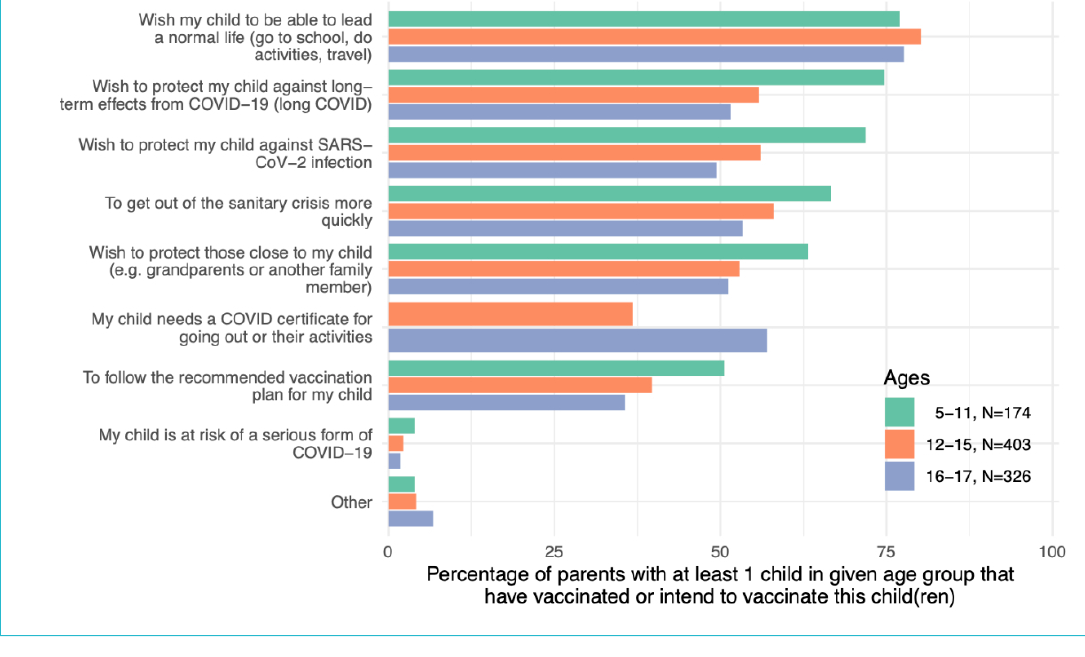
Figure 2: Reasons for deciding or wanting to vaccinate children. Parents of children in the given age groups were asked their reasons for de- ciding or intending to vaccinate their children. Multiple choices were possible. Parents of children aged 5–11 years were not asked about the need for a COVID certificate because this age group did not require one for any activities in Switzerland.